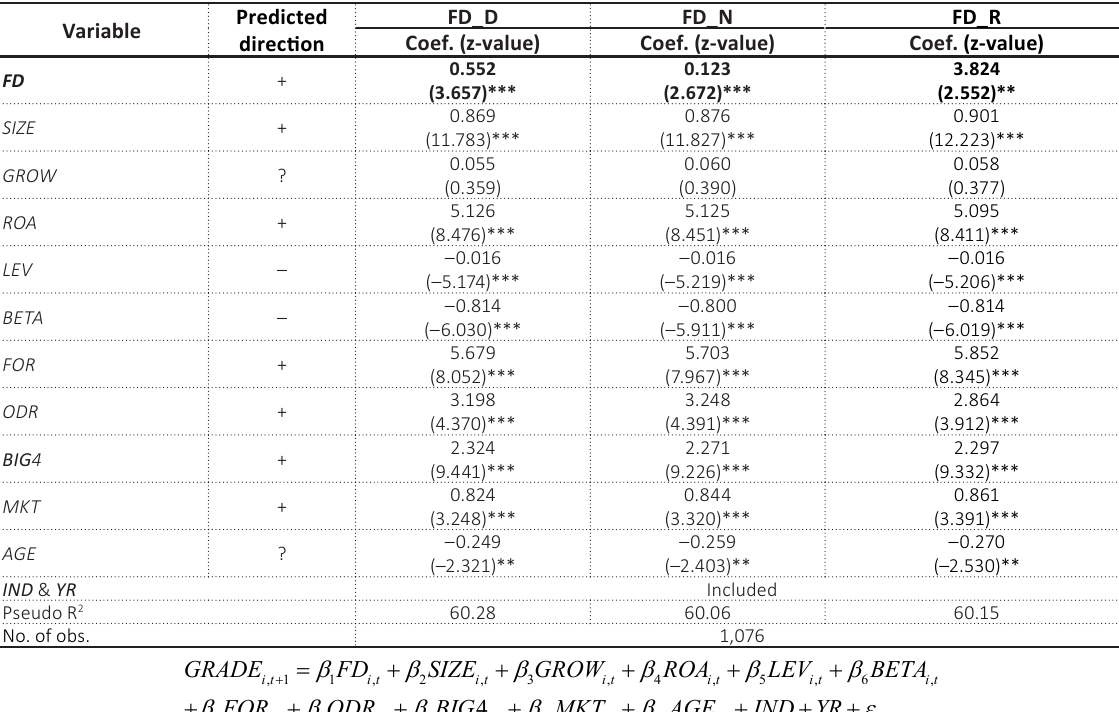
Table 1. Effect of female directors on corporate bond credit ratings ( H1a ) Variable